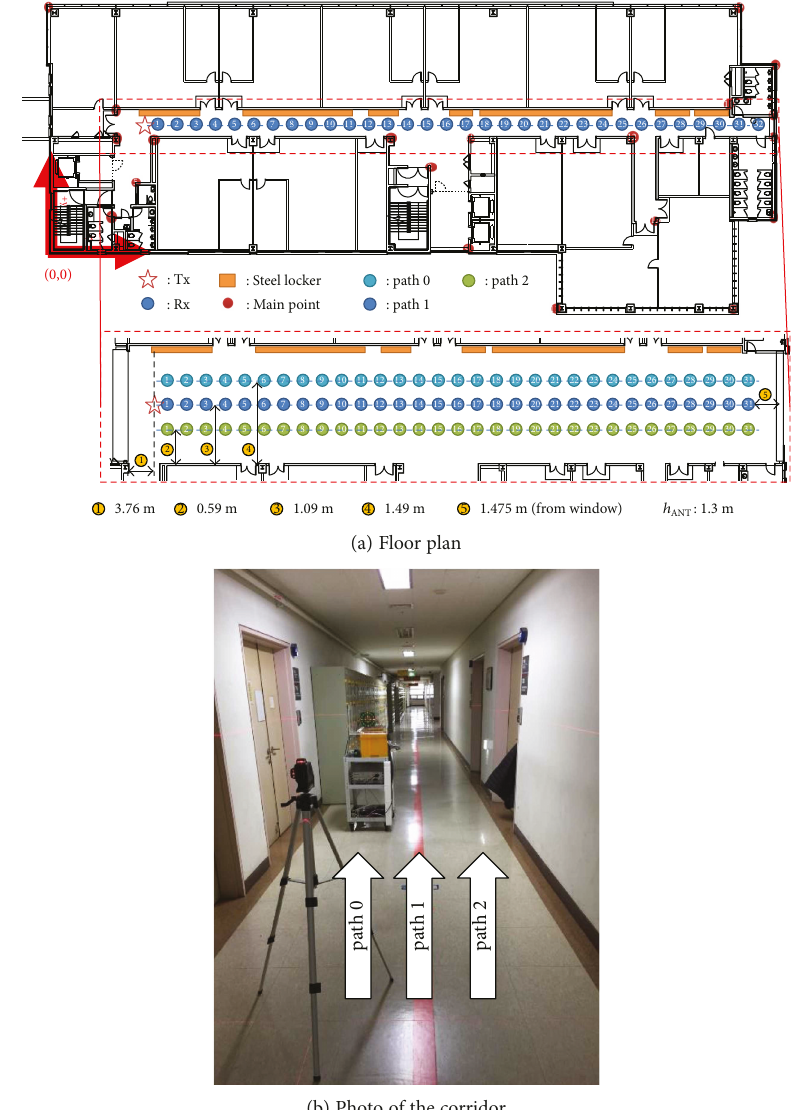
Figure 5: Measurement in the